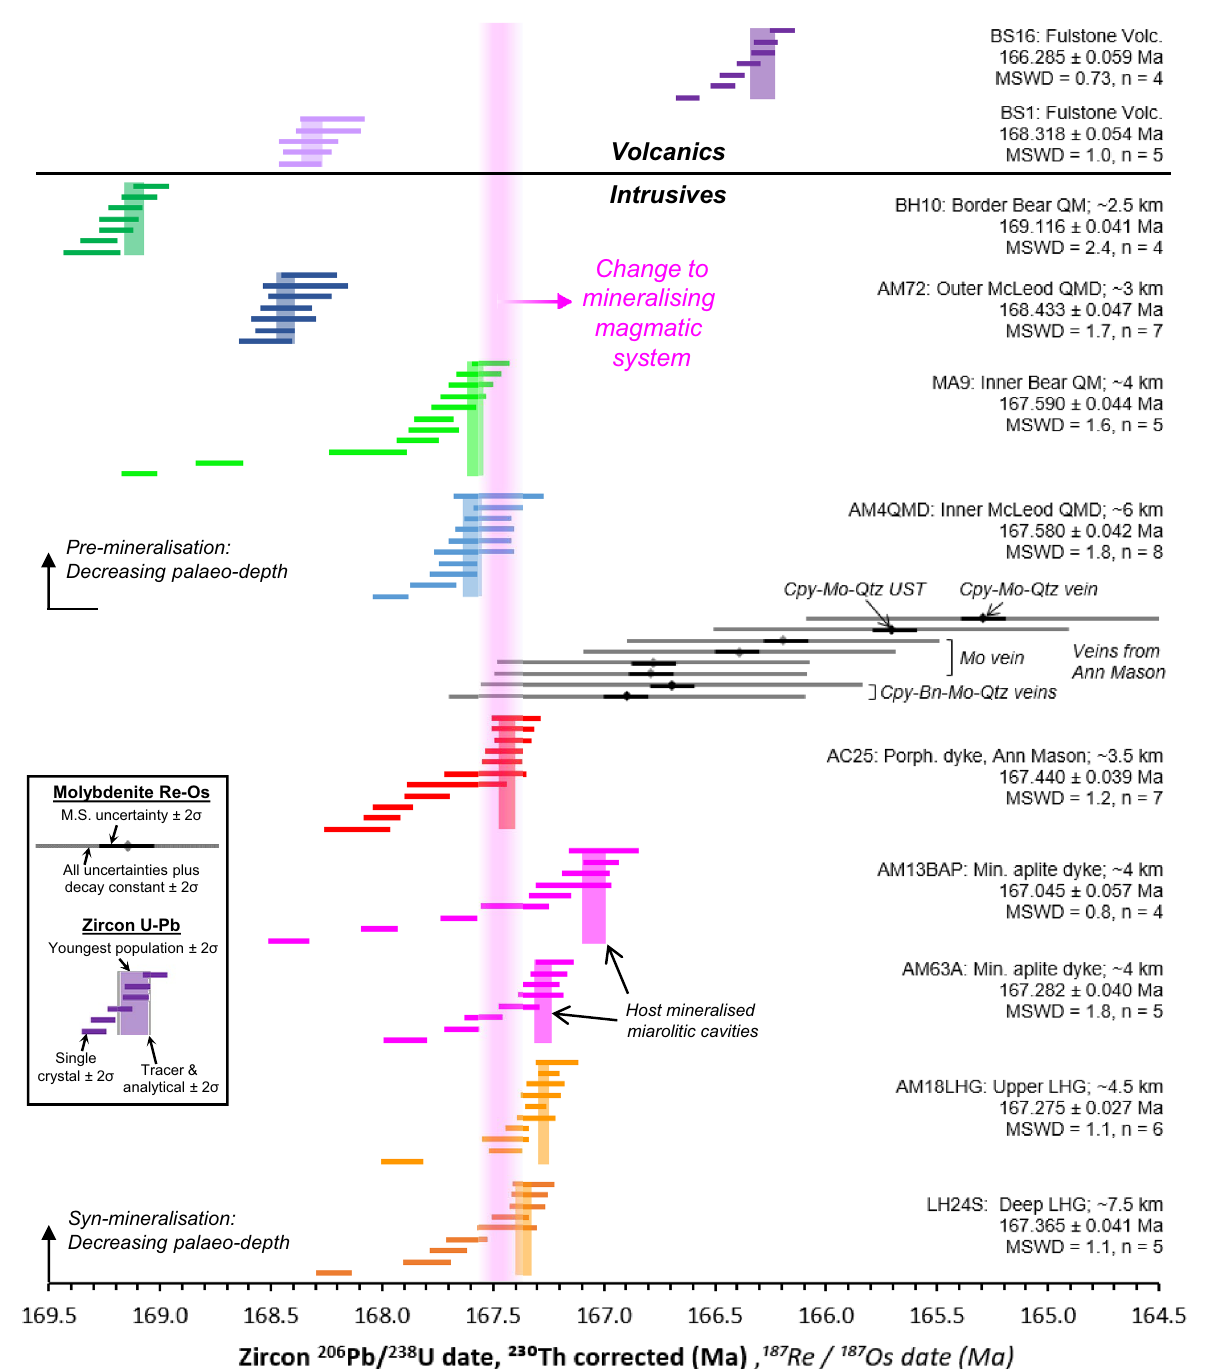
Figure 4. Geochronological framework for the Yerington porphyry system: Zircon single grain U–Pb CA–ID–TIMS and molybdenite Re-Os geochronological framework for samples spanning the Yerington magmatic system. Pre- and syn-mineralisation intrusive samples grouped and plotted in order of approximate palaeo-depth, after 27 . Sample details in Supplementary Data 2. We take the weighted mean of the youngest population of zircon dates that formed a statistically acceptable Mean Square Weighted Deviation (MSWD, or chi squared) as the best approximation for the crystallisation of the host magma. Cpy = chalcopyrite, Bn = bornite, Mo = molybdenite, Qtz = quartz, UST = unidirectional solidification texture, Porph. = porphyry, Min. = mineralised, M.S. = mass spectrometry. Error bars at 2σ. For comparison of Re-Os with U–Pb data, expanded uncertainties for Re-Os (typically ± 0.8 Myrs) and decay constant and tracer uncertainty for U–Pb data (typically ± 0.08 Myrs, represented in legend) should be taken into account (Refer to Supplementary Data